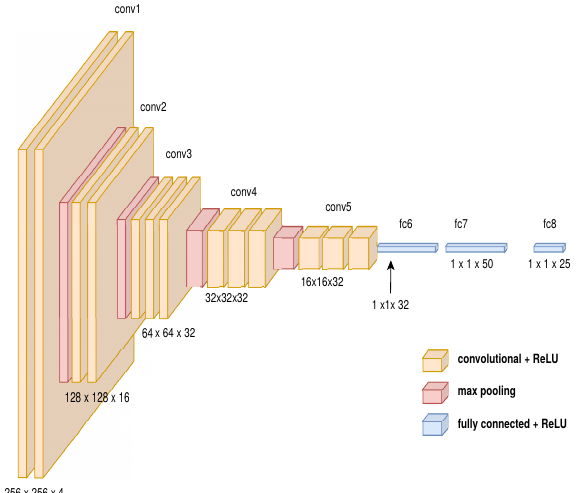
Figure 13. Proposed architecture with transfer learning. ( a ) Input sample. ( b ) Transfer learning network. ( c ) Generated path network.